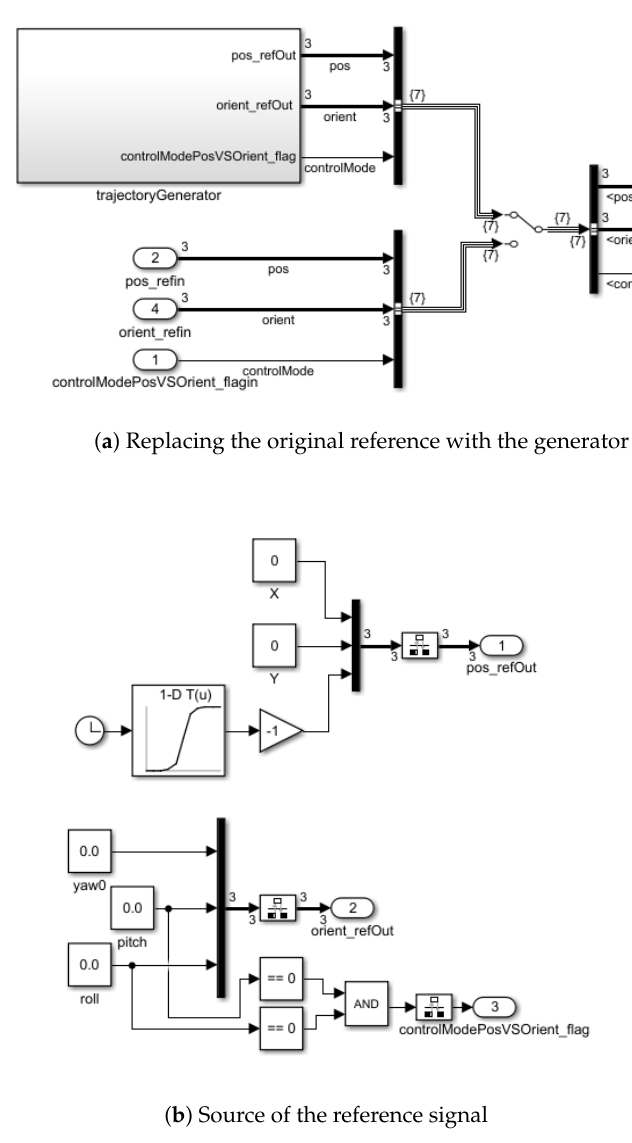
Figure 11. Building a signal generator to provide reference to the